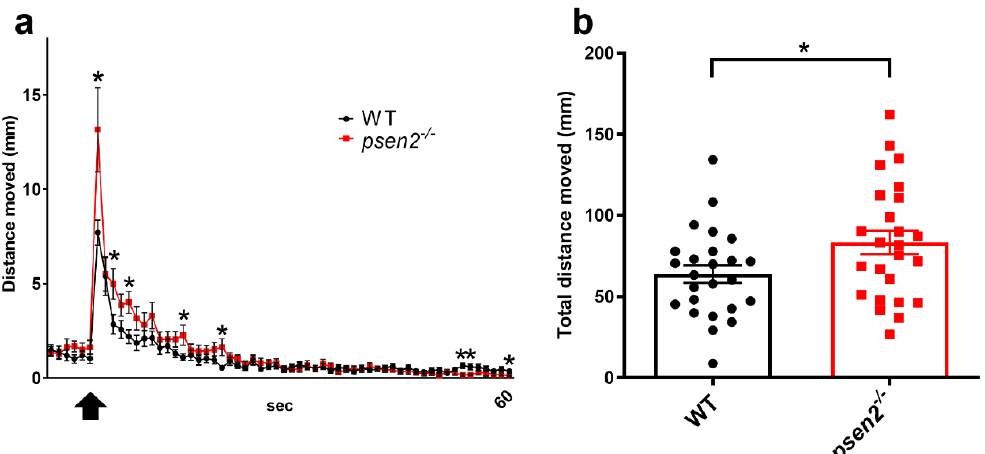
Figure 3. Effect of Psen2 absence on zebrafish larval behavior: vibrational startle analysis. ( a ) Plots of mean distance moved in response to a repetitive tapping stimulus in WT and psen2 − / − larvae at 8-dpf. Black arrow indicates the beginning of tapping stimulation. ( b ) Quantification of the total distance moved by larvae during the entire experiment. Data were generated from 3 independent experiments. n = 25 larvae/condition. Values represent the mean ± SEM. Statistical significance was determined by two-tailed Student’s t-test (* = p < 0.05, ** = p < 0.01).